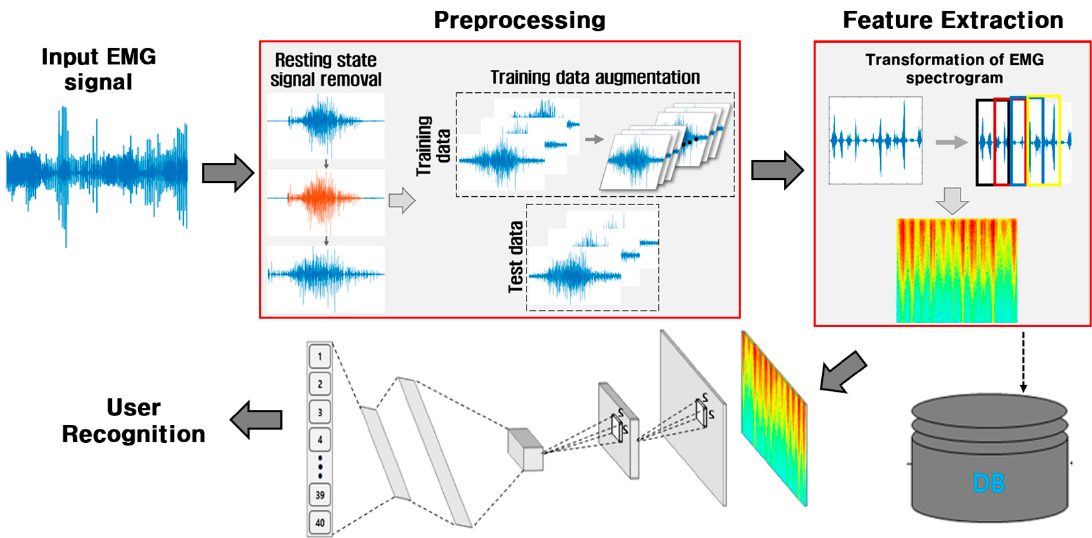
Figure 4. Flowchart of proposed sEMG spectrogram-based user identification.